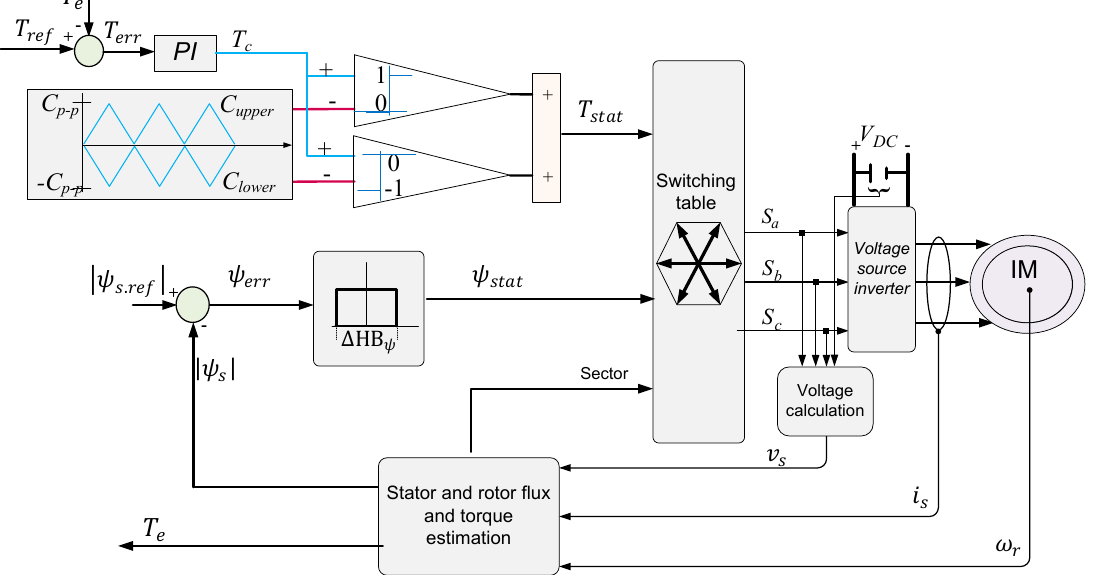
Figure 1. Conventional structure of constant-frequency torque regulator–based direct torque control (CFTR-DTC). PI—proportional-integral regulator; IM—induction motor.